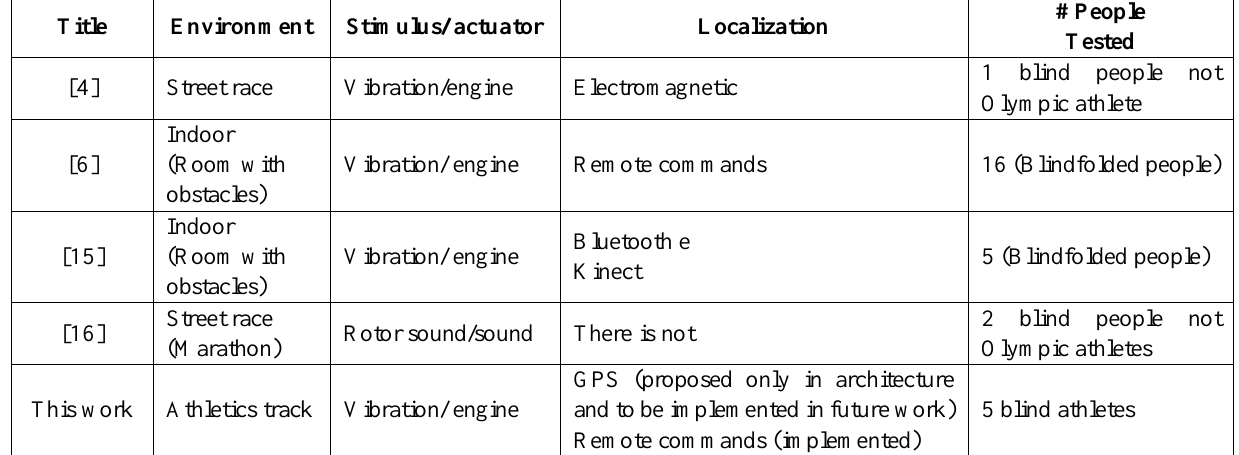
Table 1: Related